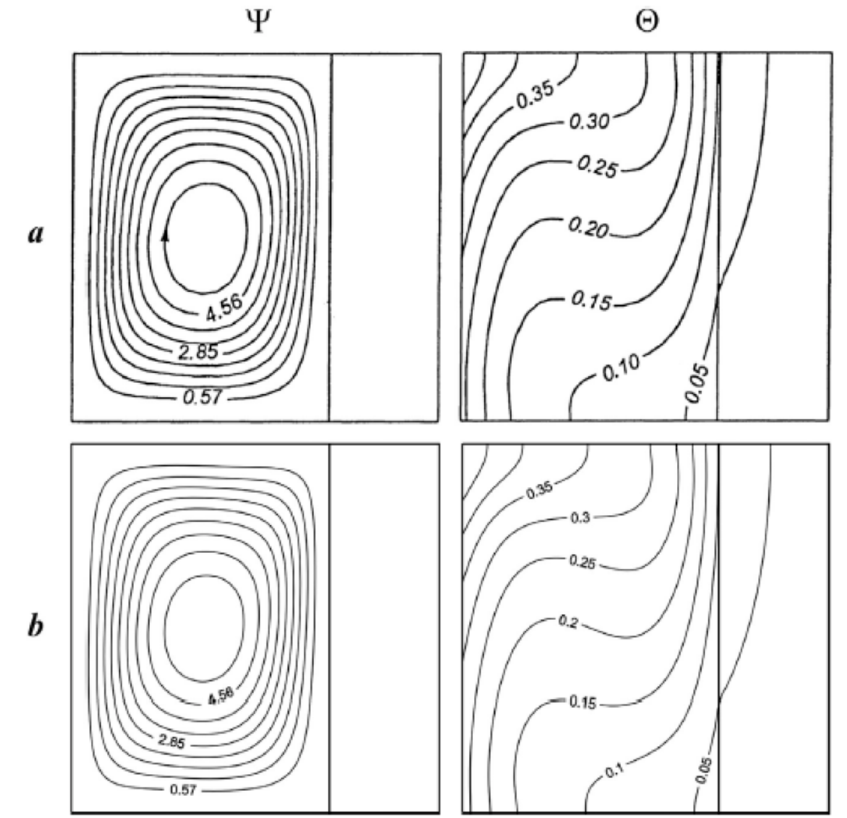
Figure 3. Streamlines Ψ and isotherms Θ of Yedder and Bilgen [27] ( a ) in comparison with present results ( b ). results ( b